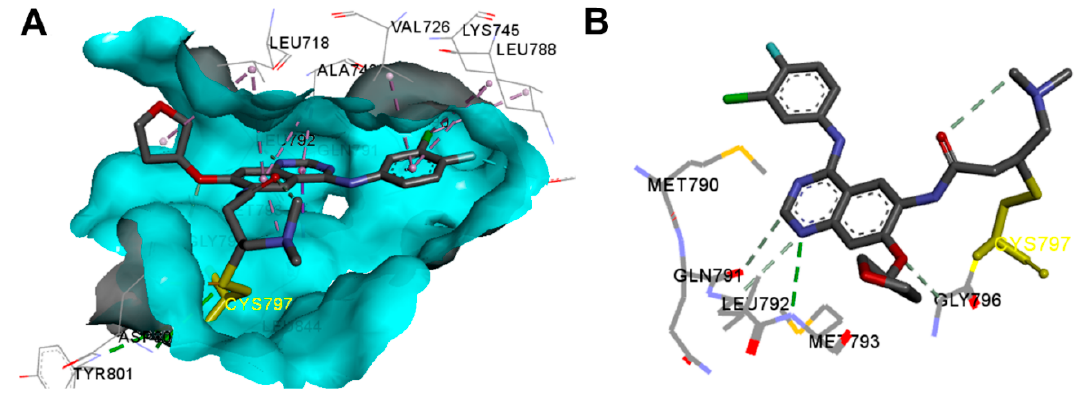
Figure 10. Binding modes of afatinib (shown as sticks) into EGFR kinase T790M (4G5P): ( A ) 3D binding mode, receptor shown as hydrogen bond surface; ( B ) 2D binding mode showing the covalent bond with Cys797 and the hydrogen bond interactions; the figure was generated using Discovery Studio Visualizer (V16.1.0.15350).